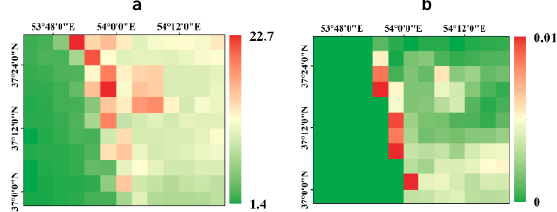
Figure 2. Variance maps of (a) LST and (b) vegetation cover during of